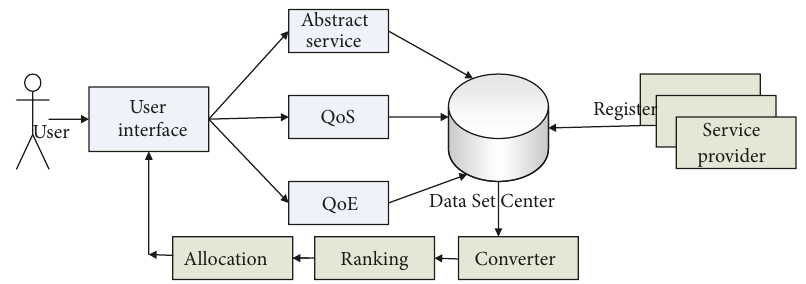
Figure 1: System overview of service